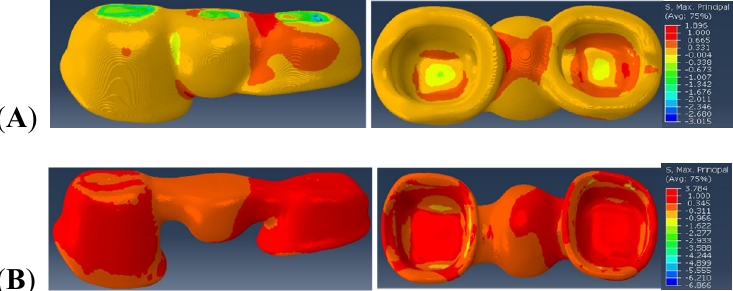
Figure 3. Stress distribution in the ( A ) Veneer and ( B ) Framework region of Model A.